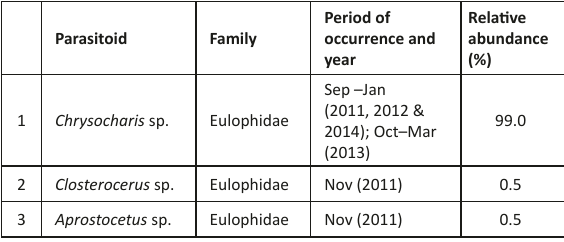
Table 1. Larval parasitoids recorded on Cashew Leaf Miner in Puttur